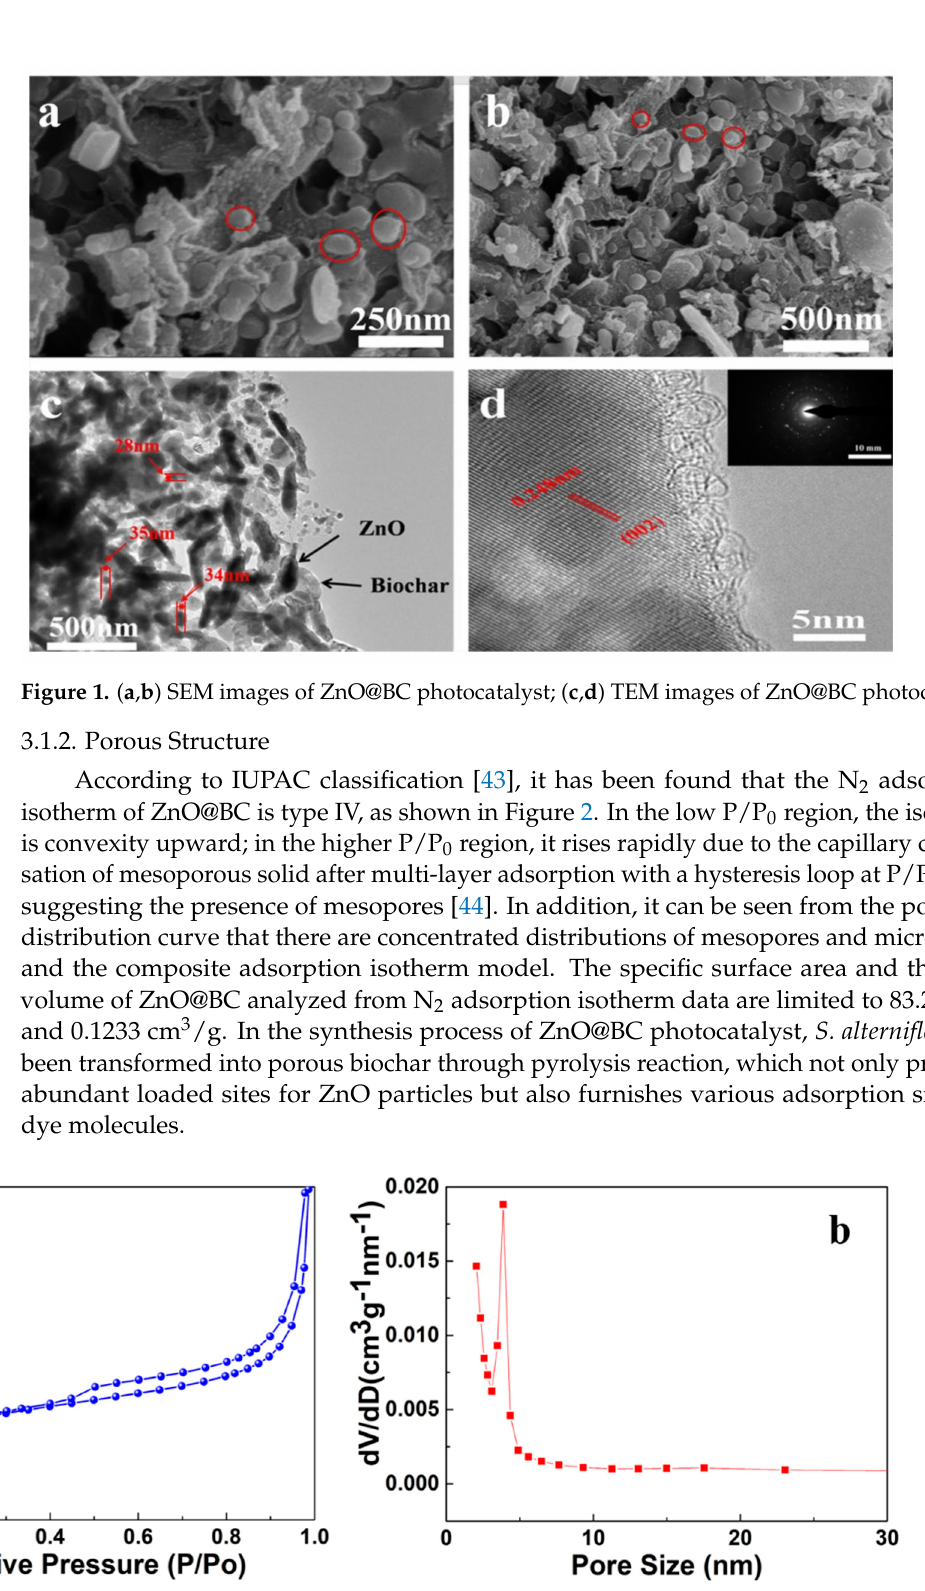
Figure 2. ( a ) N 2 adsorption-desorption isotherm; (b) pore size distribution of